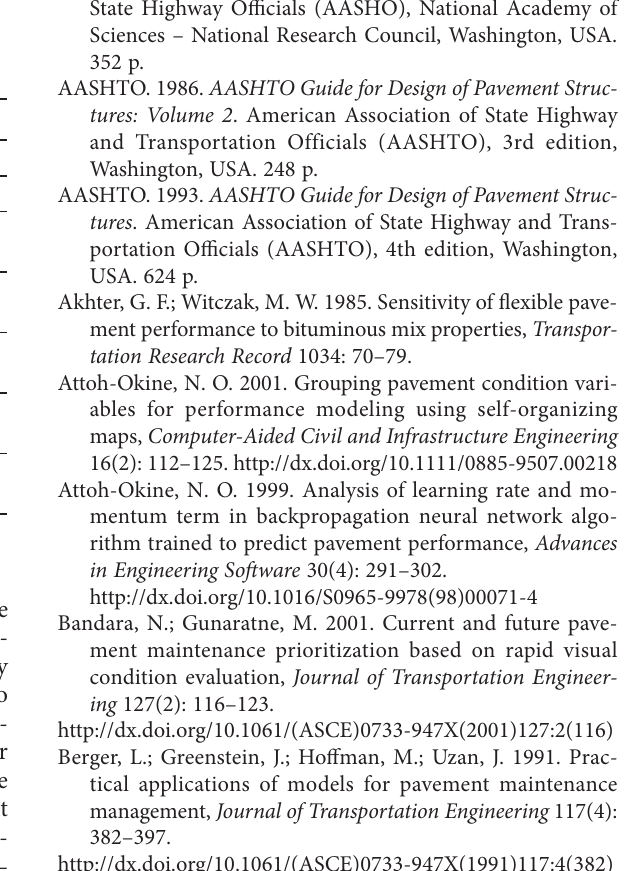
Fig. 16. Comparison of desired value with estimated value